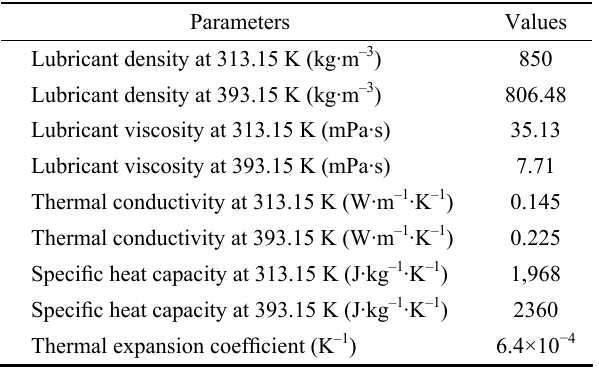
Table 1 Lubricant properties at different lubrication